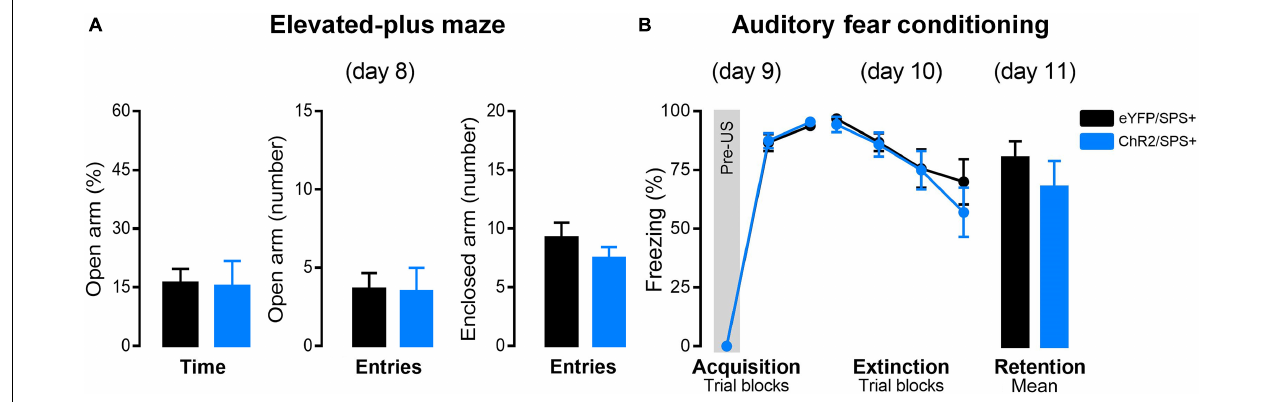
FIGURE 3 | The effects of right-IL optogenetic stimulation on anxiety and extinction of conditioned fear in SPS rats. (A) Effect of the right-IL optical stimulation of SPS rats on anxiety-like behavior evaluated in the elevated plus-maze (day 8). Bars represent mean + SEM of the percentage of open arm time and the number of open and enclosed arm entries of eYFP/SPS+ ( n = 9) and ChR2/SPS+ ( n = 8) rats. (B) ChR2 activation of right IL neurons does not affect fear acquisition, extinction, or retention of SPS+ rats. Acquisition (day 9): data are shown as mean ± SEM of the percentage of freezing in blocks of three trials (Pre-US is an average of the two pre-tones and the tone before the shock. Extinction: data are shown as mean ± SEM in blocks of five trials (Total of trials: 20 CS+). Retention: data are shown as mean + SEM of the average of five trials (5 CS+). SPS-: no single prolonged stress; SPS+: single prolonged